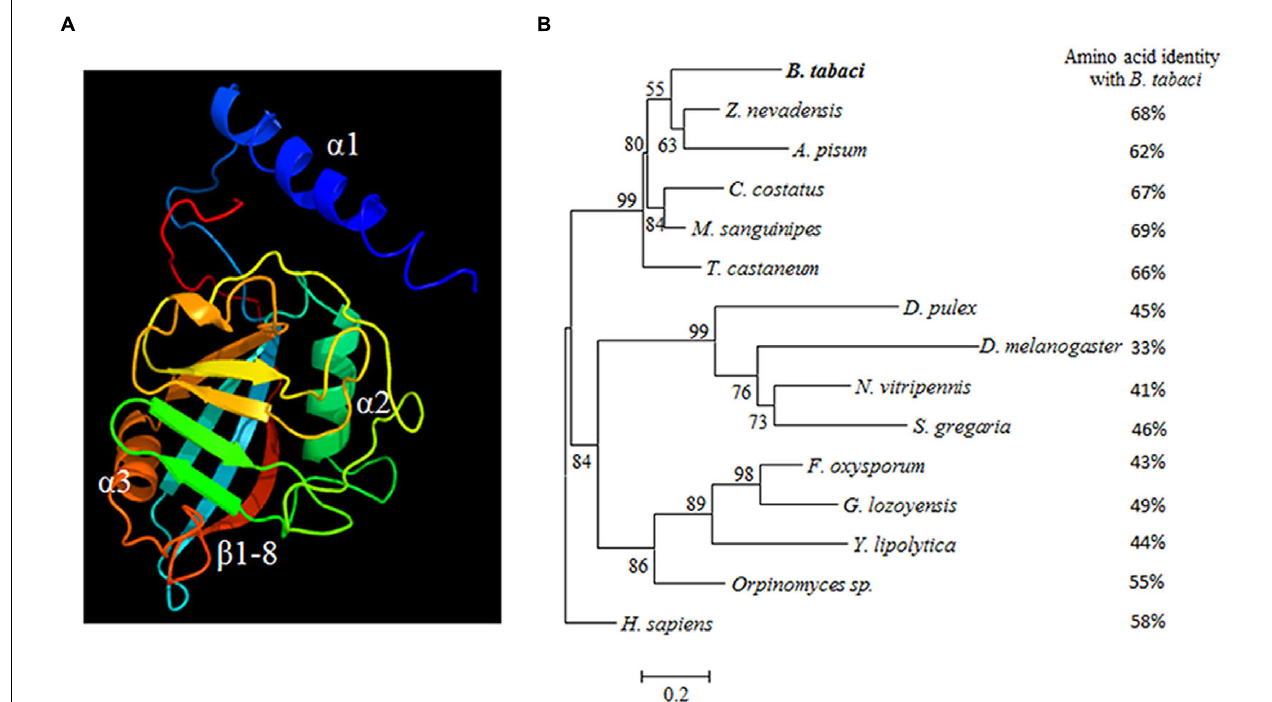
FIGURE 2 | (A) The 3-D structure of B. tabaci -CypB. The β -strands and α -helices are shown. (B) Phylogenetic tree of B. tabaci -CypB and other arthropods, fungal species and H. sapiens , were constructed using MEGA 6 with maximum likelihood method. Numbers next to the branches indicated bootstrap value of each internal branch in the phylogenetic tree nodes from 1000 replicates. Cyclophilin B sequences include Zootermopsis nevadensis ( KDR13508); Acyrthosiphon pisum (NP 001156707); Cyphomyrmex costatus (KYN04146 ); Melanoplus sanguinipes ( ALX00032); Tribolium castaneum (XP 971028); Daphnia pulex (EFX68543); Drosophila melanogaster (NP 476656); Nasonia vitripennis (XP 001602615); Schistocerca gregaria (AEV89763); Fusarium oxysporum (EXL62949); Glarea lozoyensis (EHK99826); Yarrowia lipolytica (XP 504296); Orpinomyces sp. (Q01490), and Homo sapiens (P23284). Amino acid sequence identity with other arthropods and fungal species and H. sapiens are given for easy